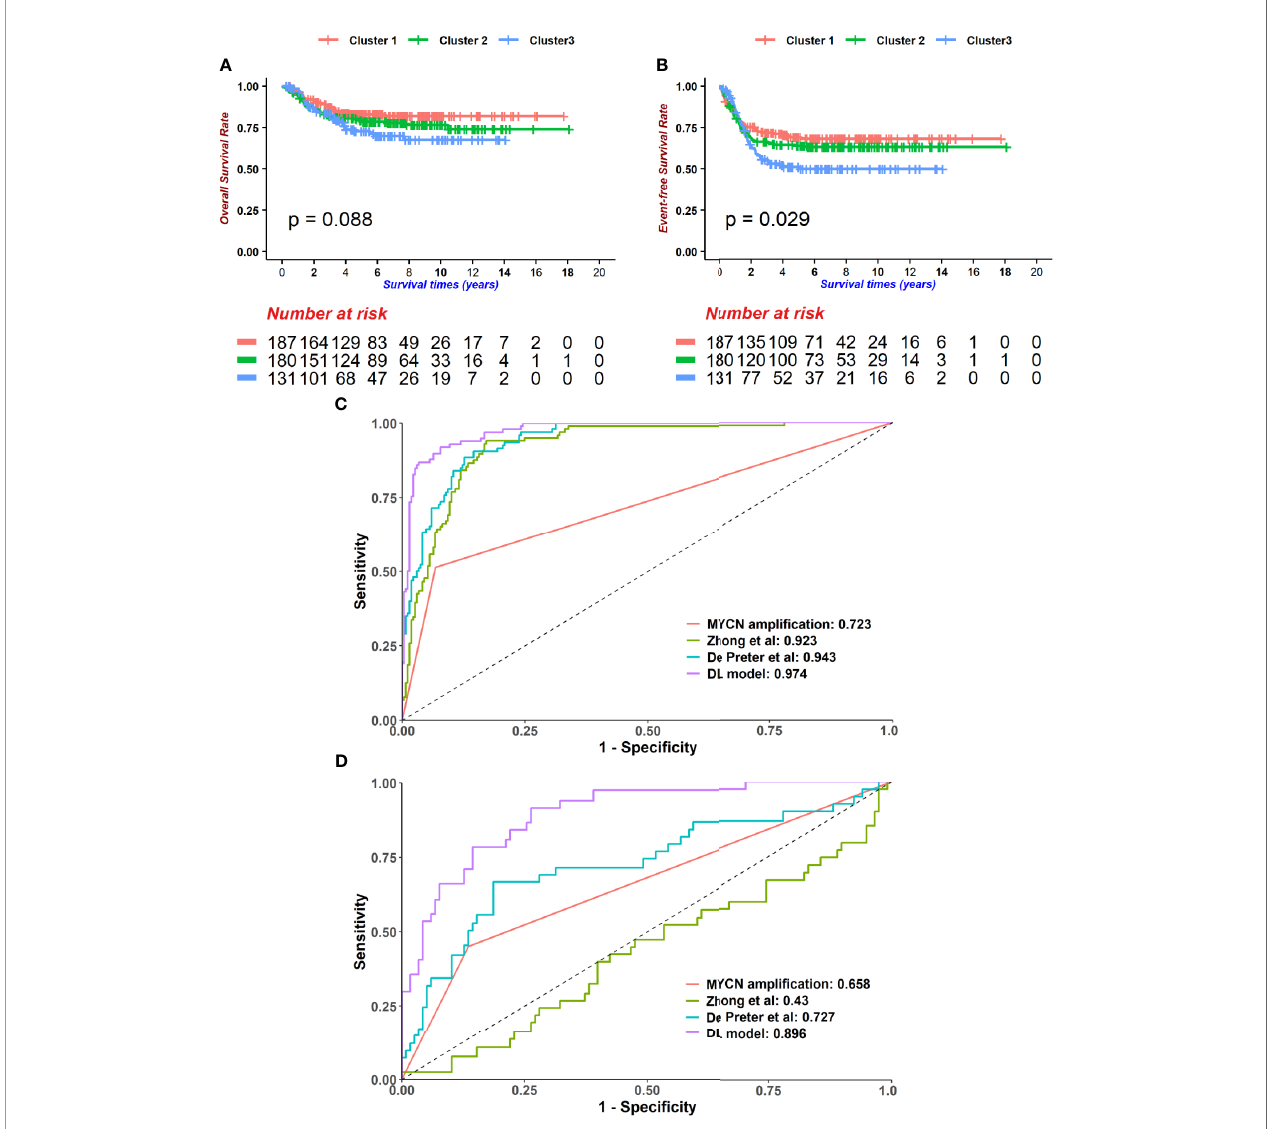
FIGURE 4 | The Deep-learning-model (DL-model) outperformed alternatives in two aspects. (A, B) We employed the Principal component analysis (PCA) method to cut features down to 200. Using 200 PCA dimensions, we distributed patients into 3 groups, which was determined by the consensus clustering method. These groups did not show prognostic value in overall survival (OS) ( A , log-rank test p = 0.088, n = 498) but event-free survival (EFS) ( B , log-rank test p = 0.029, n = 498). (C, D) Compare with other models ( MYCN status, 4-gene-signature by Zhong et al. and 42-gene-signature by De Preter et al.), our DL-model received the highest AUCs of 5-year-survival ROC curves in GSE49710 (C) and EMTAB (D) cohorts.